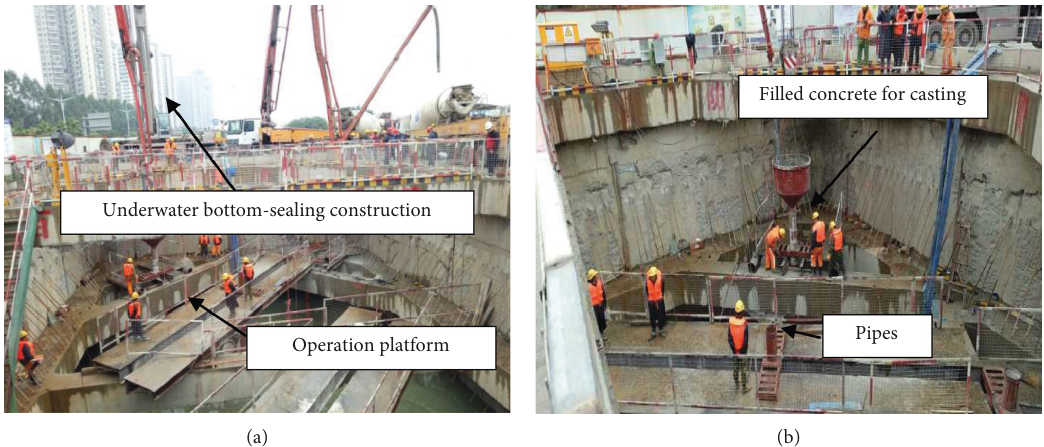
Figure 9: Construction of underwater bottom-sealing and filled concrete.